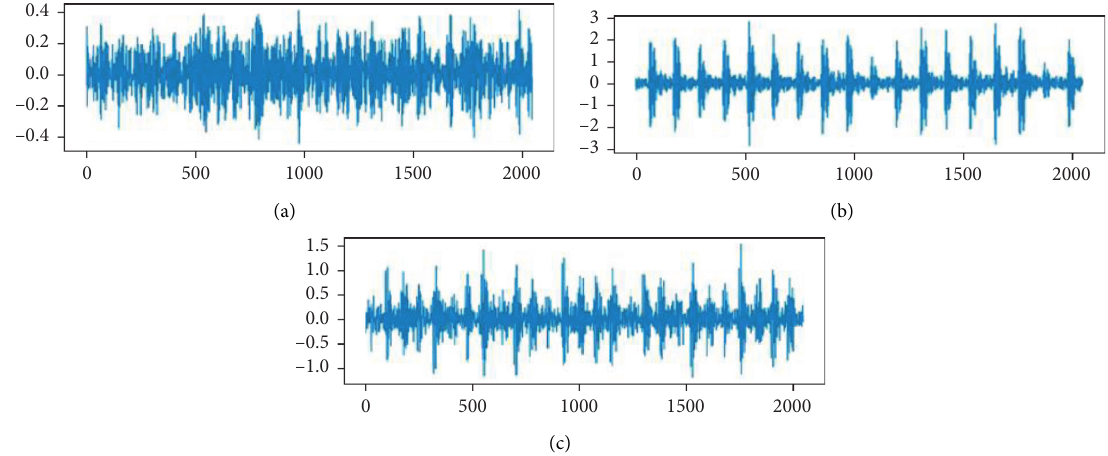
Figure 5: The original data of (a) RE fault, (b) IR fault, and (c) OR fault with 0.007-inch damage diameter.